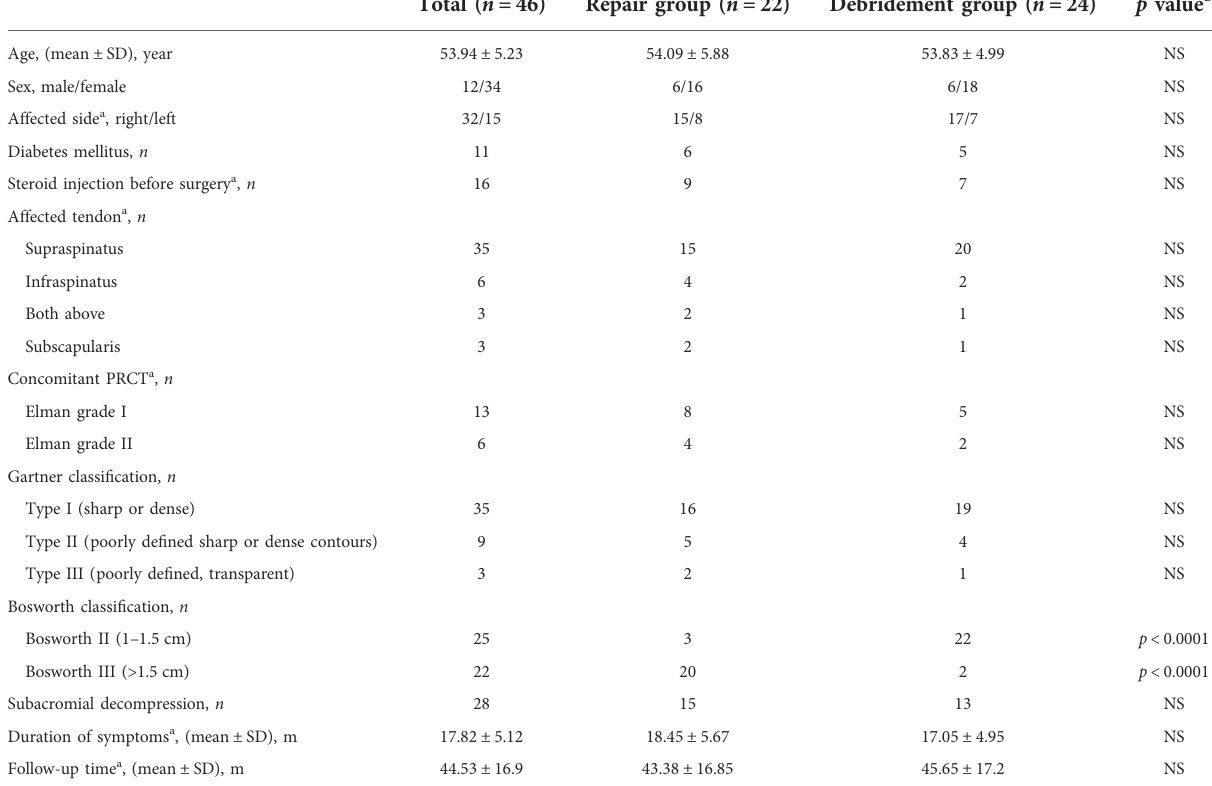
TABLE 1 Demographic baseline data of the included patients ( n =46).